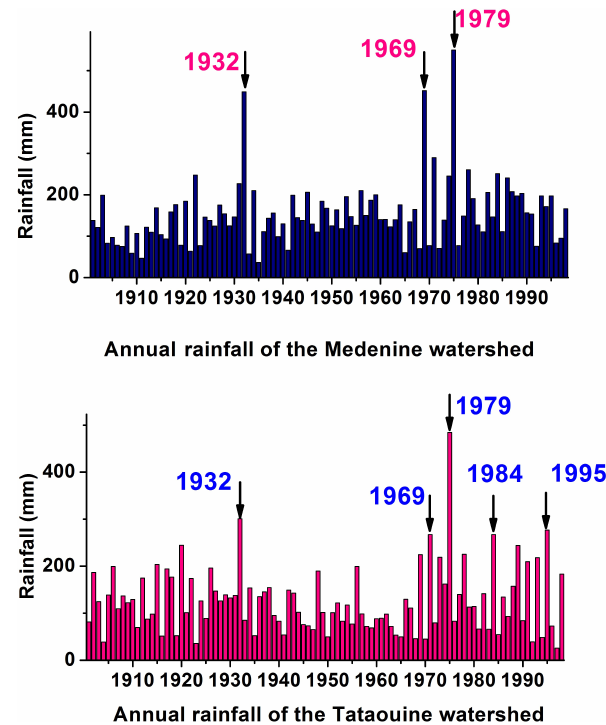
Figure 2. Variation in the annual precipitations of the Medenine and Tataouine meteorological stations during the period between 1900 and 2000 (DGRE,